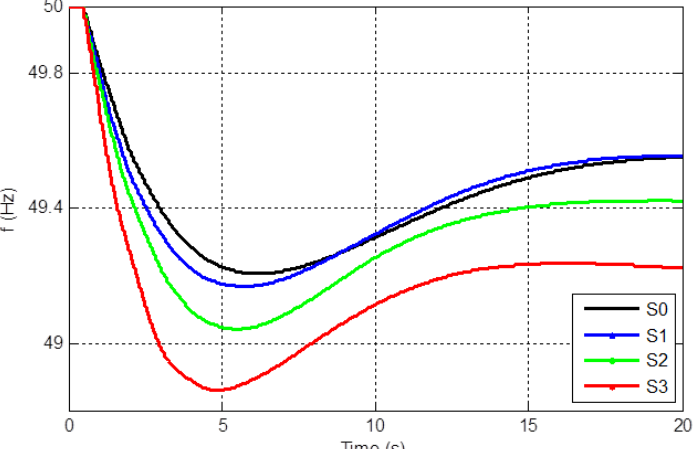
Figure 5. Frequency response with PV-PPs without FFR